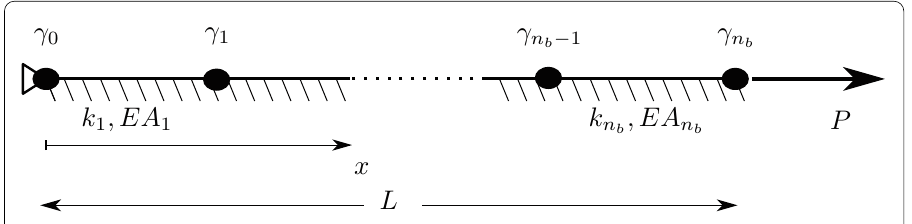
Fig. 1 Linear elastic straight bar on an elastic support, with n b sections. The bar is fixed at the start and has a concentrated load at the